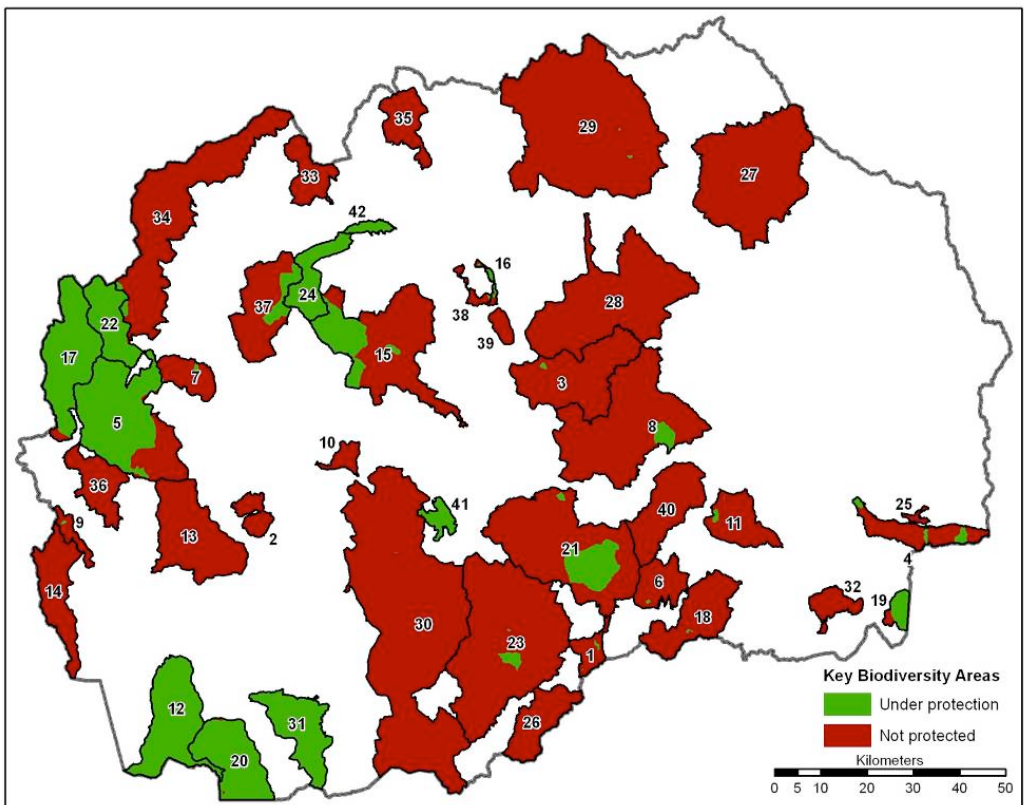
Figure 3. Key Biodiversity Areas in Macedonia, as identified from the Important Plant Areas and Important Bird